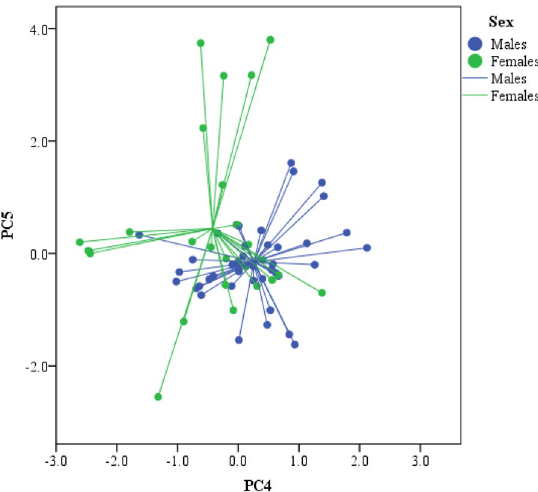
Figure 1. PC4 and PC5 individual factor scores extracted from the PCA for relative proportions of lipophilic compounds in feces of male (blue) and female (green) Iberian wolves ( Canis lupus signatus ). Individual points are related to the centroid for all samples of each sex.